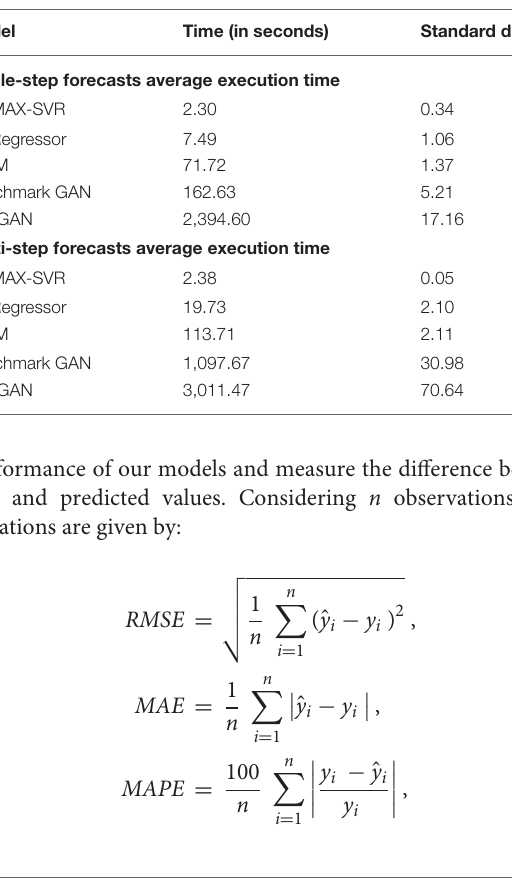
TABLE 7 | Average execution times of the considered models (10 runs on a single stock). We ran our experiments on a Microsoft Windows 10 (Version 21H1),